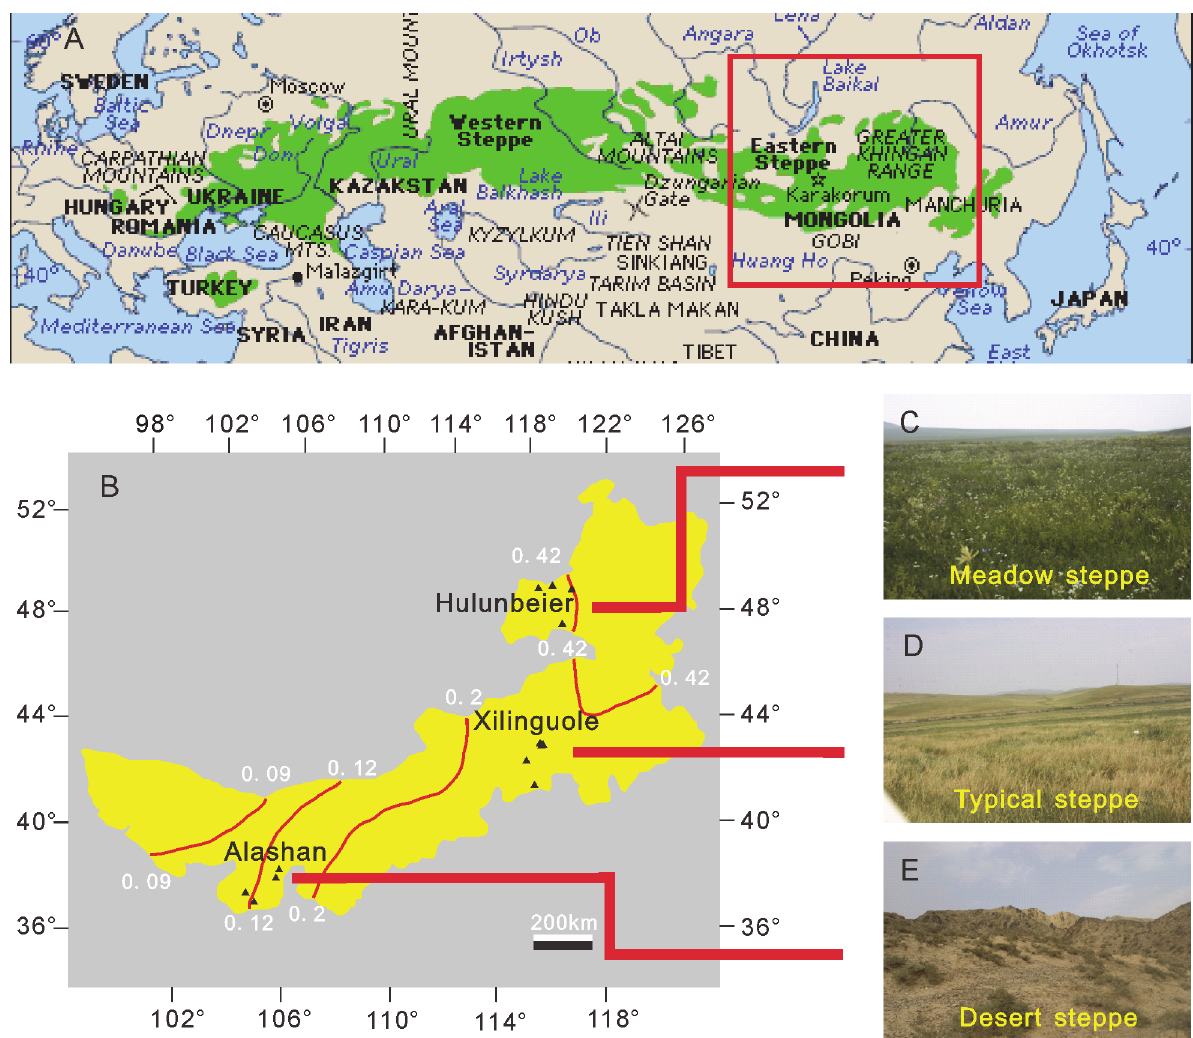
Fig 1. Maps showing the sampling localities of 3 steppe types in Inner Mongolia, eastern Eurasia. A. Map showing the extent of the Eurasian steppe from http://davidderrick.files.wordpress.com. B. Map showing the extent of Inner Mongolia, and the surface soil sampling sites ( ▲ ); red lines are the isolines of mean annual humidity (redrawn from [30]). Scale bar represents 200 km. C, D and E represent images of meadow steppe, typical steppe and desert steppe respectively.